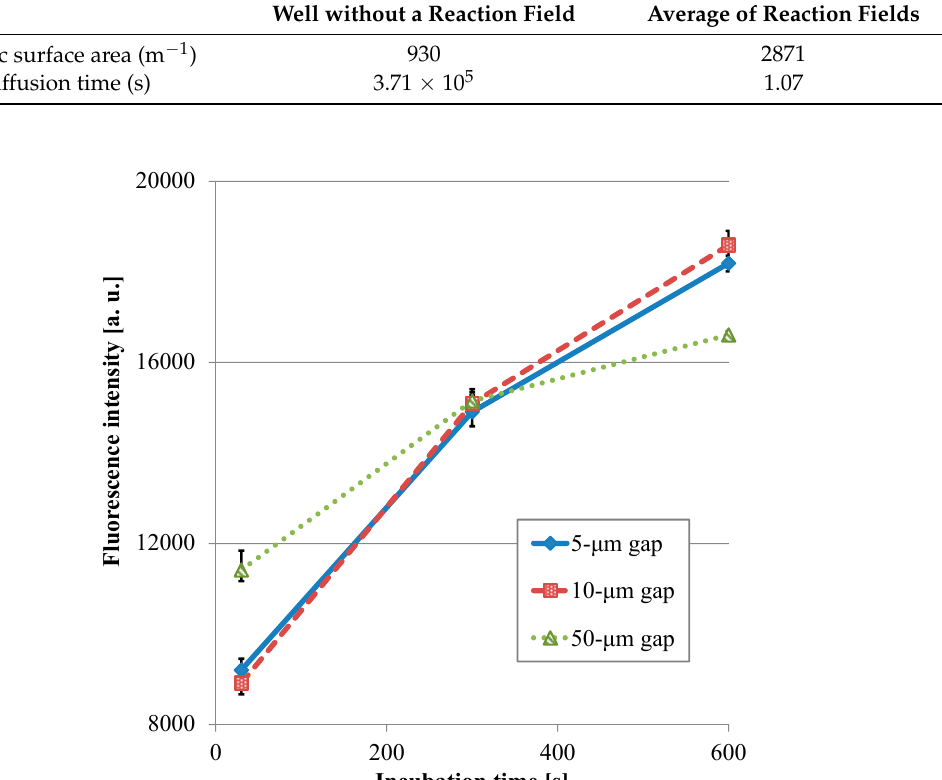
Figure 8. Transitions of the fluorescence intensity in the well with the film-stack reaction fields with the micro-pillars array having different dimensions in relation in relation to HRP-IgA incubation time. All fluorescence intensities are the same with Figure 7. Error bars are the maximum and minimum intensities.